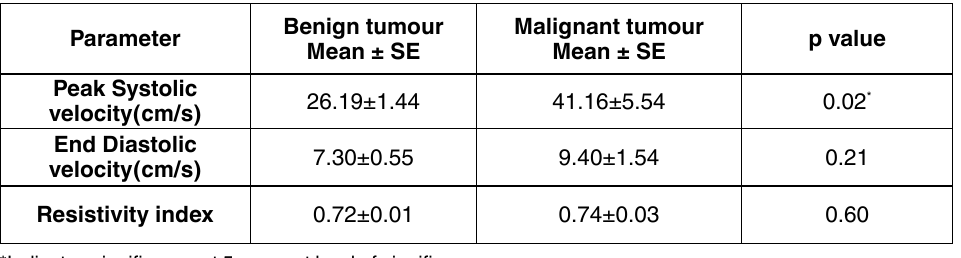
table 3. Ultrasonographic parameters evaluated by Spectral Doppler for the different groups